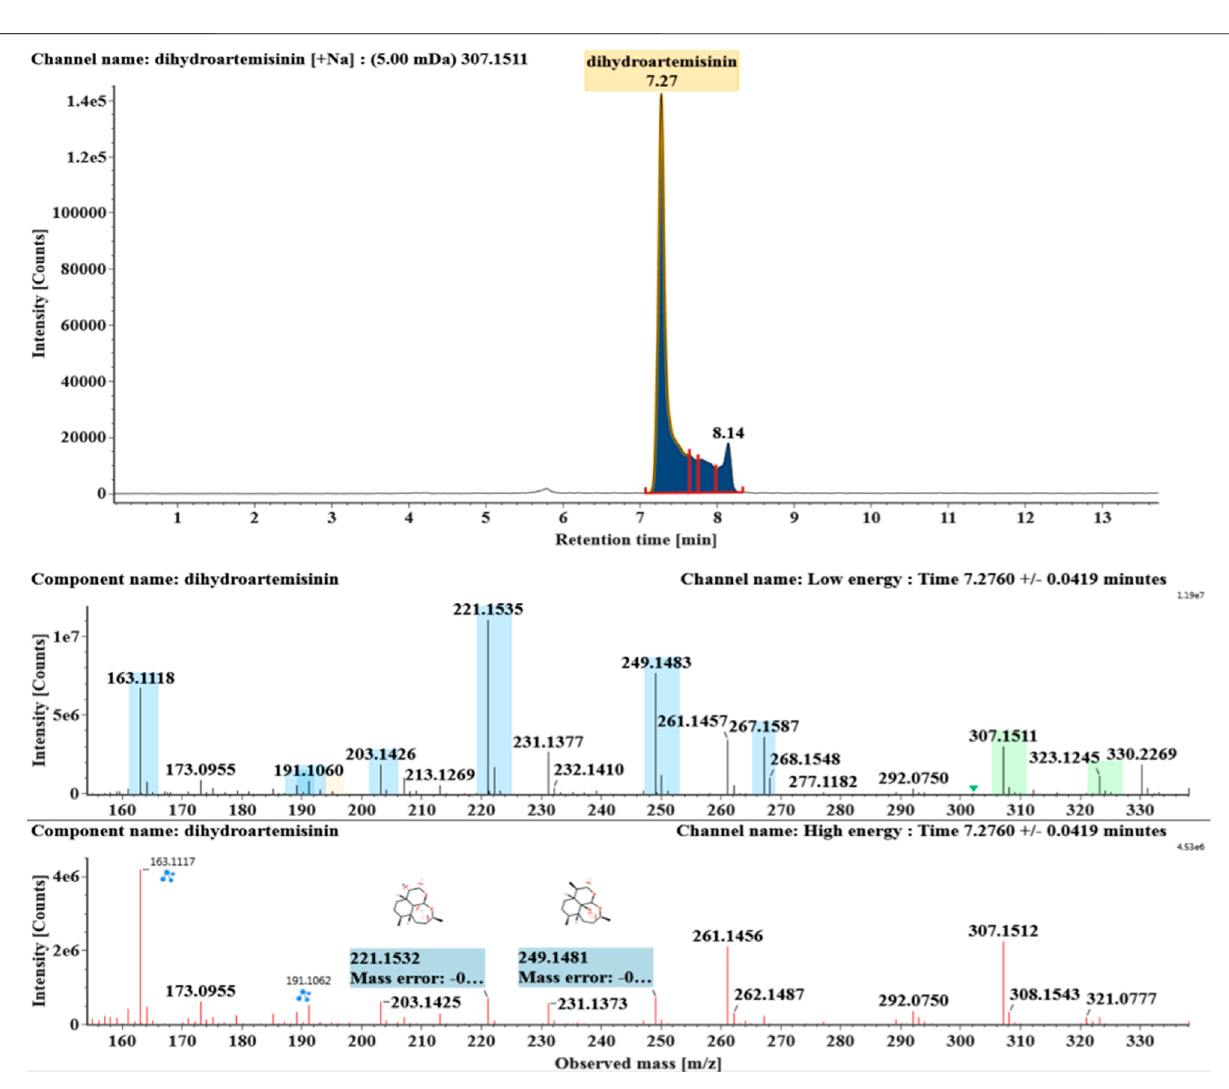
Frontiers in Chemistry |